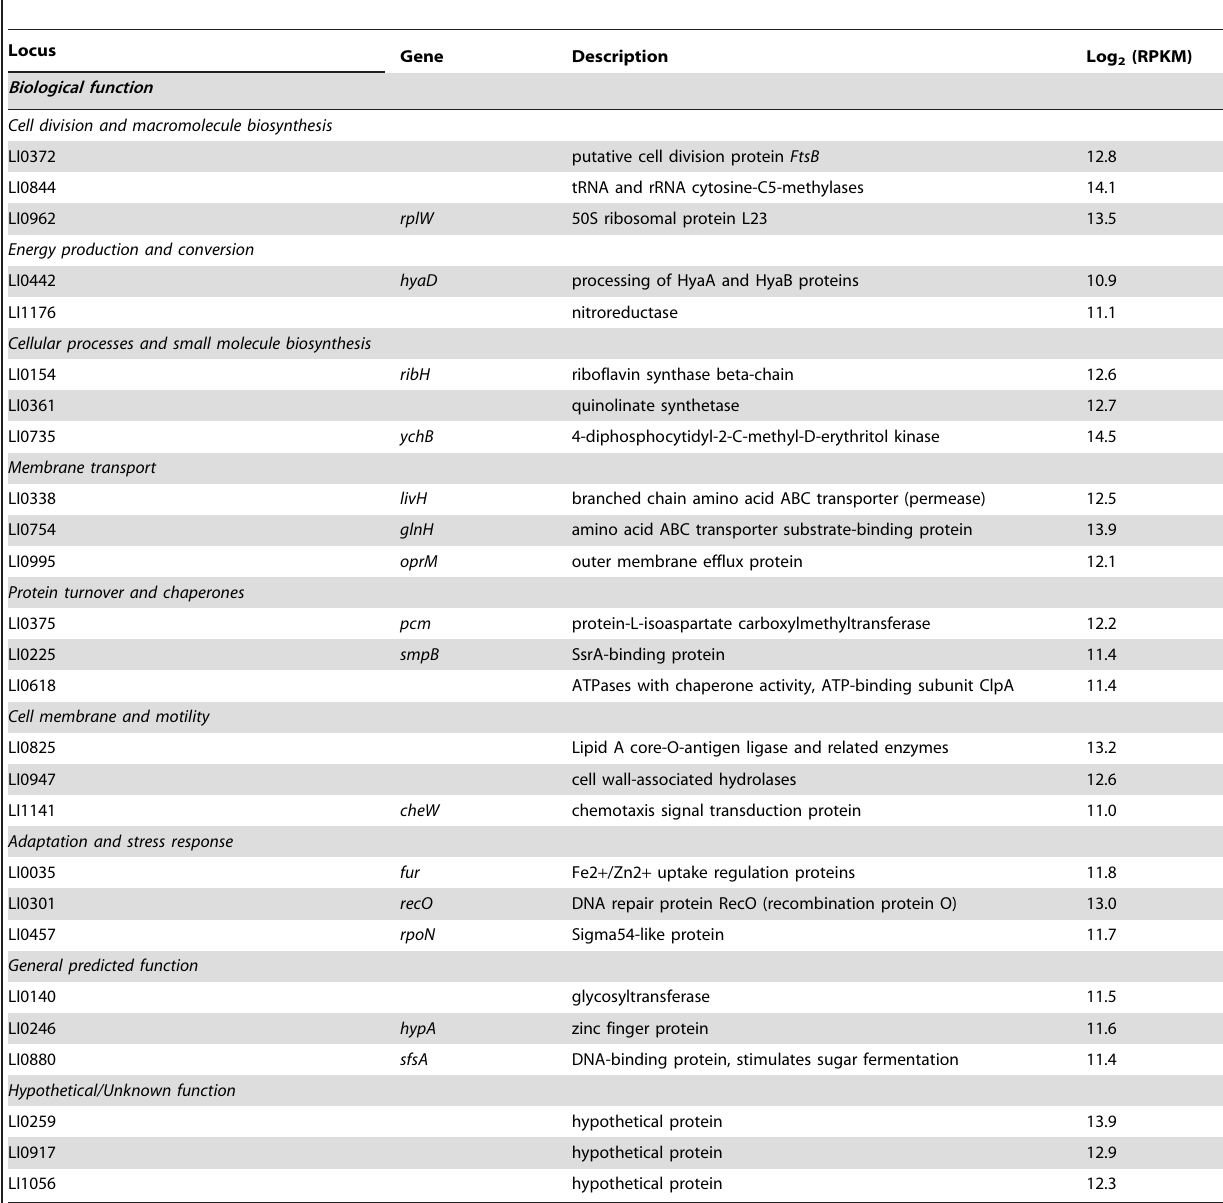
Table 1. Chromosomal genes showing highest transcript levels exclusively expressed by the pathogenic variant of the L. intracellularis isolate PHE/MN1-00 according to the putative biological